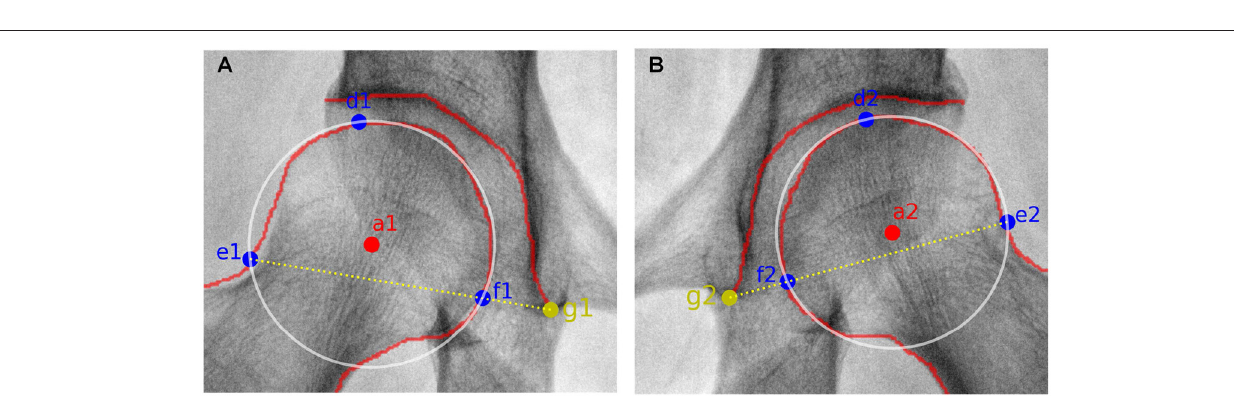
FIGURE 3 | Sketch maps of getting the circle representing the femoral head. (A,B) correspond to results from the right and left femoral head. a 1,2 refer to the central point of the right and left femoral head, respectively. d 1,2 and e 1,2 represent the uppermost and outermost points of the right and left femoral head, respectively. g 1,2 correspond to the lower edge points of the right and left acetabulum, respectively. As to f 1,2 , they are the intersection points of the connection line (i.e., e 1,2 and g 1,2 ) and the contour of right and left femoral head,